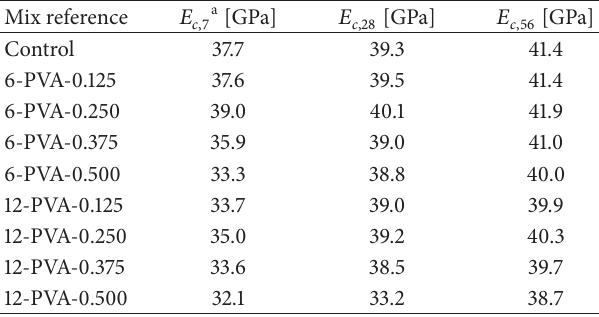
Table 7: Elastic modulus of control and FRC at 7, 28, and 56 days.